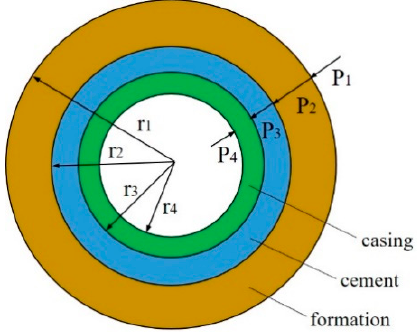
Figure 14. Schematic diagram of casing–cement sheath–wall surrounding rock combination.